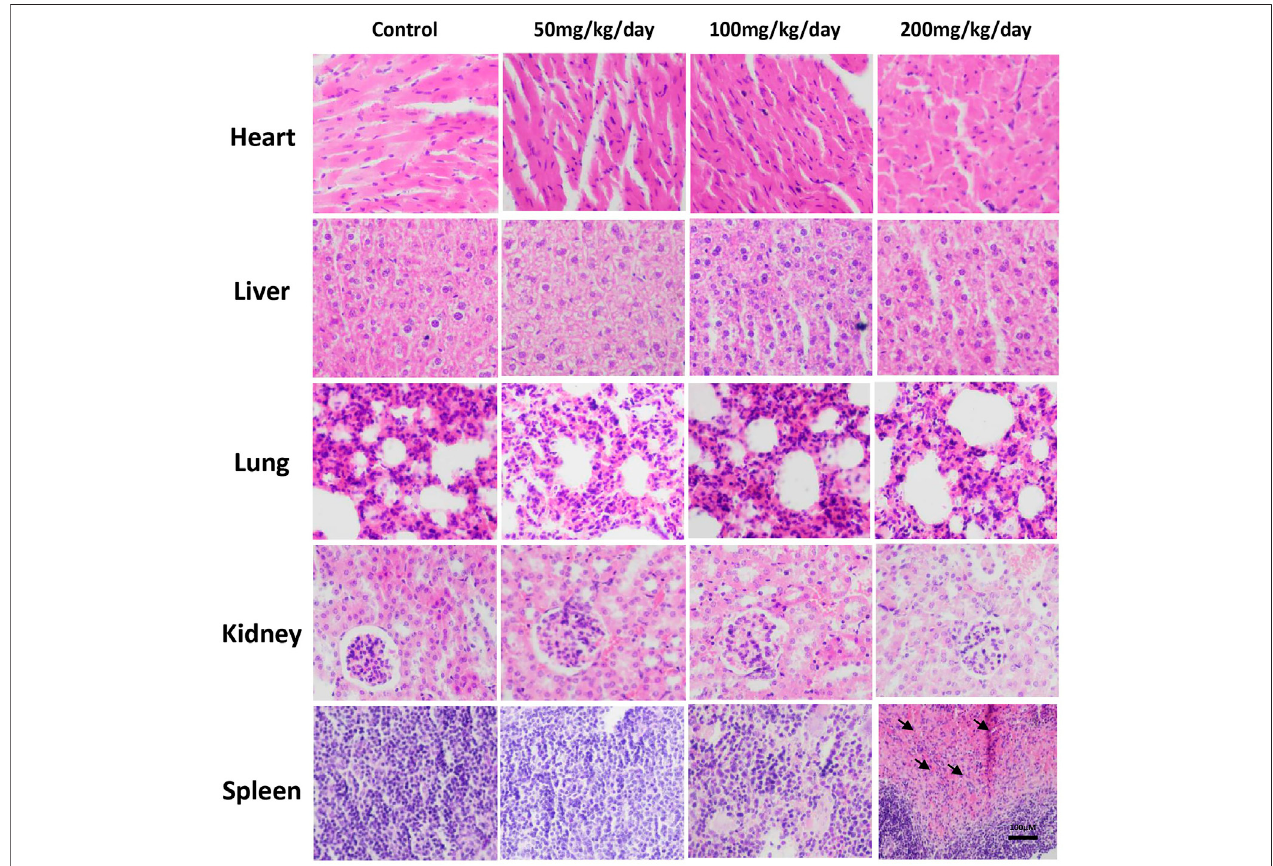
FIGURE 2 | Histopathological study of mouse major organs following oral administration of jaranol for 28 days. Scale bar = 100 μ M (black arrow: bleeding).